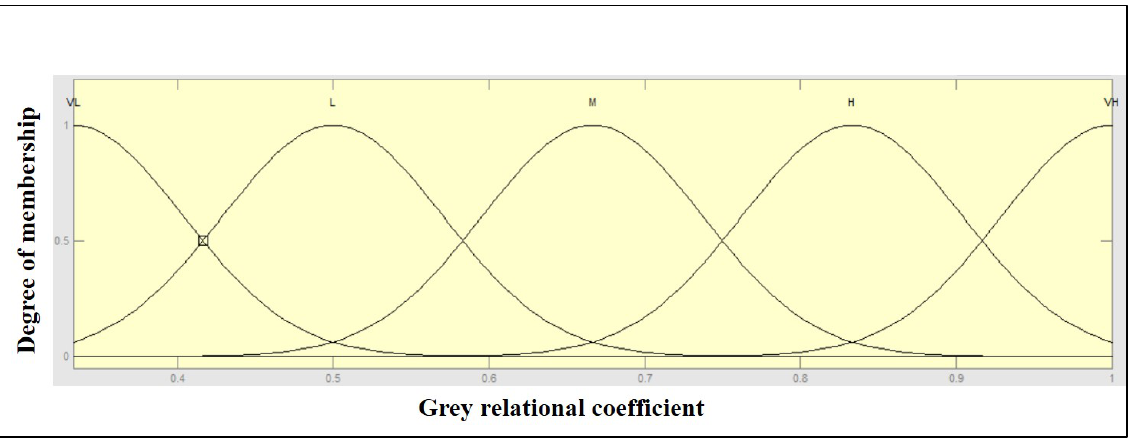
Figure 7. Input GRC Gaussian function with very low (VL), low (L), medium (M), high (H), and very high (VH).